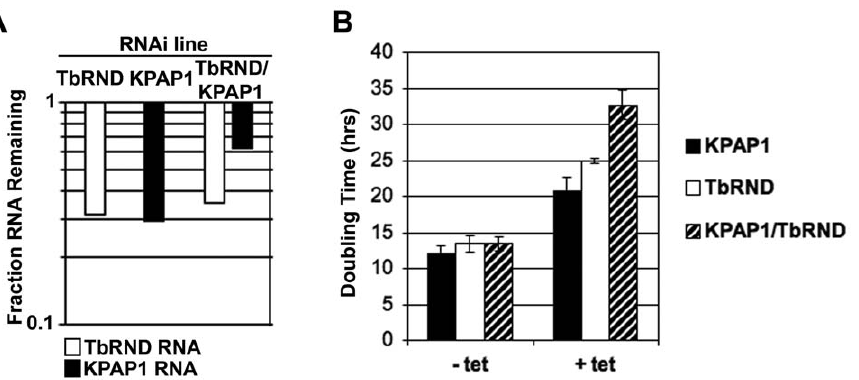
Figure 1. Growth of single and dual KPAP1 and TbRND RNAi cell lines. A. Extent of target RNA depletion. Relative transcript levels in tetracycline (tet) - induced RNAi cells compared to levels prior to RNAi induction, as determined by quantitative RT-PCR normalized to 18S RNA. B. Doubling time before and after tet induction of RNAi for TbRND, KPAP1, and dual-TbRND/KPAP1 RNAi cell lines. Doubling time was calculated using cell numbers on days 3 to 10 following tet induction, the time period when growth was linear for all strains in all conditions when plotted on a logarithmic scale.